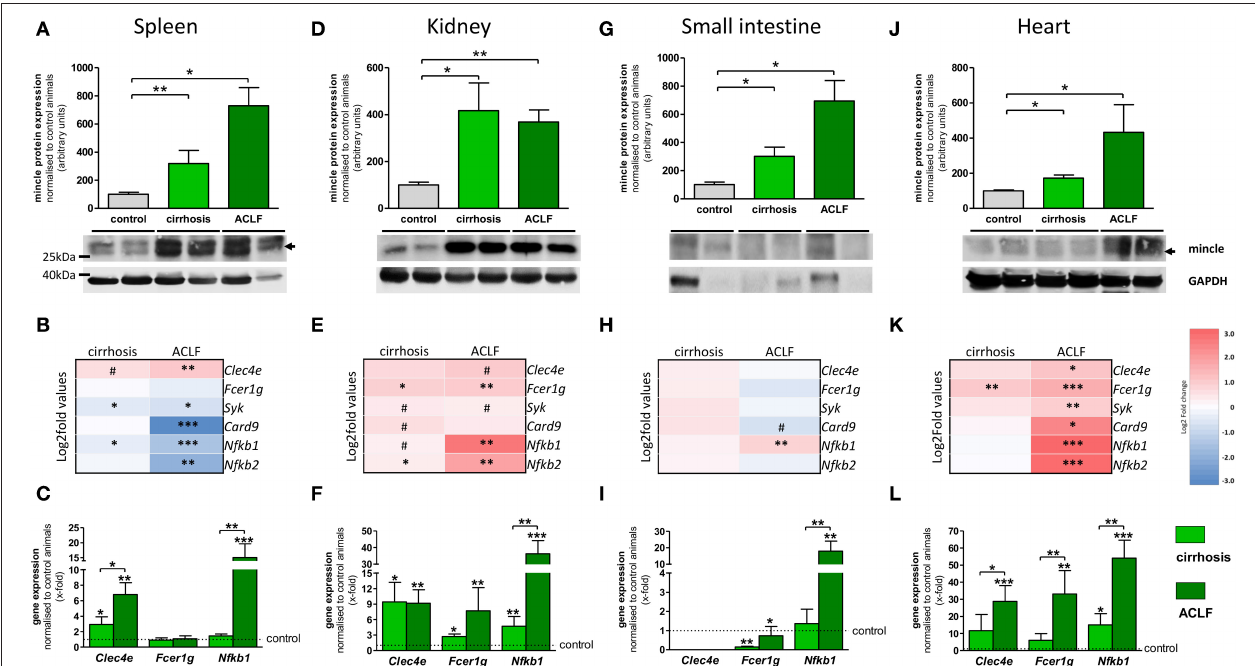
FIGURE 3 | Extrahepatic mincle in cirrhosis and ACLF. (A–C) Mincle in the spleen. (A) Representative Western blot showing protein levels of mincle in control, cirrhotic, and ACLF rats and quantification of the Western blots. (B) Heatmap of mincle and downstream signaling maker expression in cirrhosis and ACLF. (C) Gene expression of Clec4e, Fcer1g and Nfkb1 in cirrhosis and ACLF. (D–F) Mincle in kidney. (D) Representative Western blot showing protein levels of mincle in control, cirrhotic, and ACLF rats and quantification of the Western blots. (E) Heatmap of mincle and downstream signaling maker expression in cirrhotic and ACLF. (F) Gene expression of Clec4e, Fcer1g, and Nfkb1 in cirrhosis and ACLF. (G–I) Mincle in small intestine. (G) Representative Western blot showing protein levels of mincle in control, cirrhotic and ACLF rats and quantification of the Western blots. (H) Heatmap of mincle and downstream signaling maker expression in cirrhotic and ACLF. (I) Gene expression of Clec4e, Fcer1g, and Nfkb1 in cirrhosis and ACLF. (J–L) Mincle in heart. (J) Representative Western blot showing protein levels of mincle in control, cirrhotic, and ACLF rats and quantification of the Western blots. (K) Heatmap of mincle and downstream signaling maker expression in cirrhotic and ACLF. (L) Gene expression of Clec4e, Fcer1g, and Nfkb1 in cirrhosis and ACLF. Arrows indicate the respective band used for quantification in cases when more than one band is shown in the representative Western blots. In heatmaps, statistical comparison was performed between cirrhosis, respectively, ACLF and sham-operated control rats. Upregulation is marked by red colors and downregulation by blue colors. * p < 0.05; ** p < 0.01; *** p < 0.001; # p < 0.1 using using non-parametric Mann–Whitney U t -test or FDR-adjusted paired t -test for data from microarray